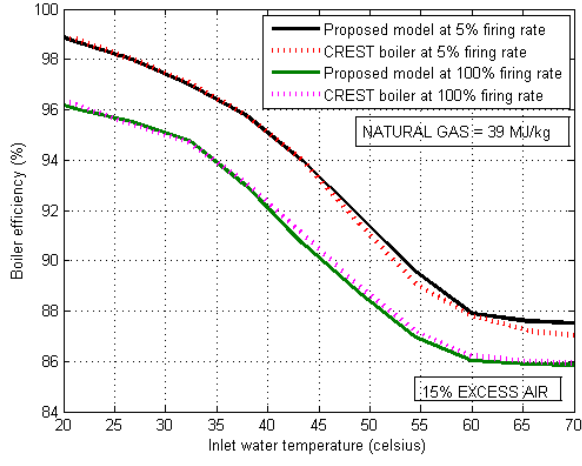
Figure 3. Effect of return (inlet) water temperature on efficiency of condensing boiler.